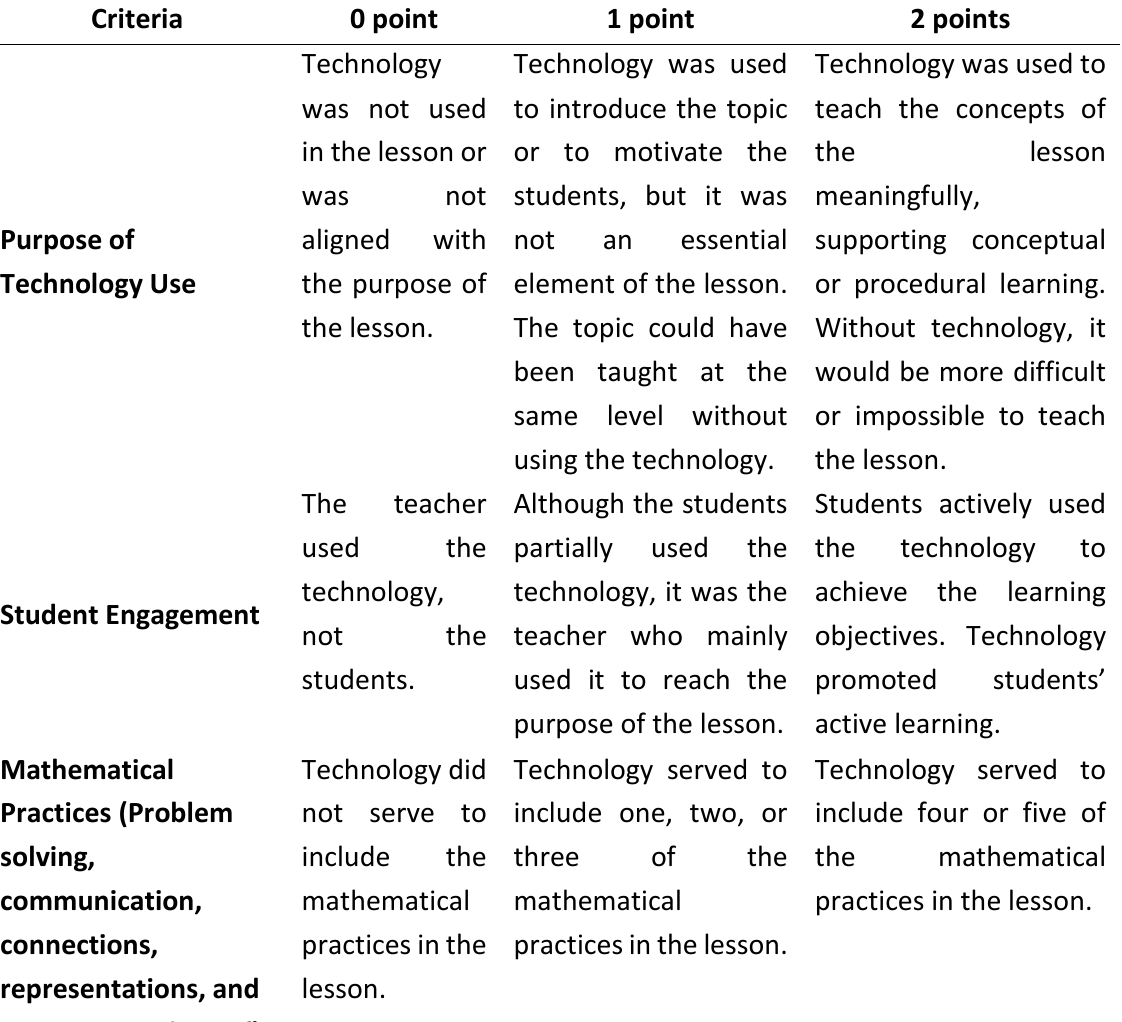
Table 2. Effective Technology Integration Rubric for Mathematics